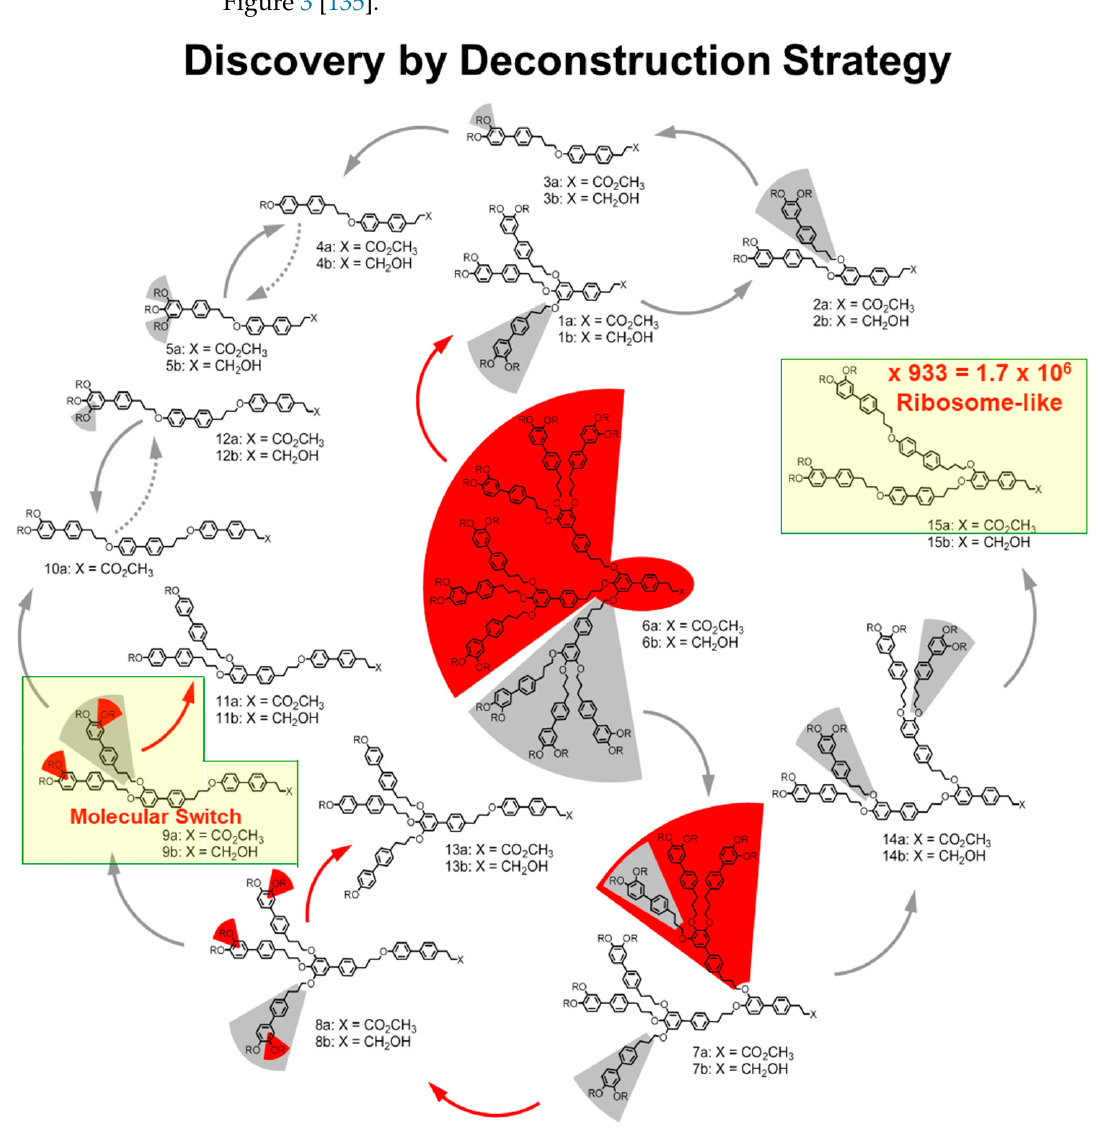
Figure 3. The deconstruction strategy of third-generation dendron (3,4BpPr-(3,4,5BpPr) 2 )12G3-X (shown in the middle) led to the discovery of new self-assembling minidendrons marked in yellow, where X = –CO 2 CH 3 for 6a and –CH 2 OH for 6b. In each step of the deconstruction (solid arrows), the fragment highlighted by the wedge of the corresponding color (red or gray) is removed, and the remaining unmarked dendron is synthesized and structurally analyzed. Yellow highlights form a molecular switch and a ribosome-size supramolecular dendrimer [135]. The Figure was adapted from [135] and modified. Copyright © 2010 WILEY-VCH Verlag GmbH & Co. KGaA, Weinheim. A previously synthesized and characterized self-assembling dendron or a structure that was never synthesized is cleaved on paper, and the imaginary new dendrons whose primary structure would not have been predicted by the generational methodology is synthesized. Their structural and retrostructural analyses is performed as in the case of the generational libraries. The deconstruction strategy to discovery is illustrated in Figure 3